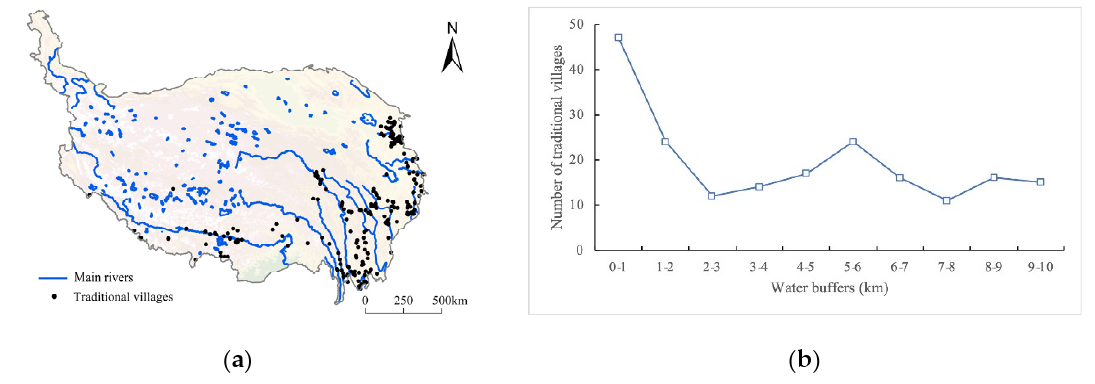
Figure 12. Distribution of traditional villages coupled with water systems on the Tibetan Plateau: ( a ) the spatial overlay analysis of village distribution and water systems; ( b ) statistics of traditional villages in different water buffers.